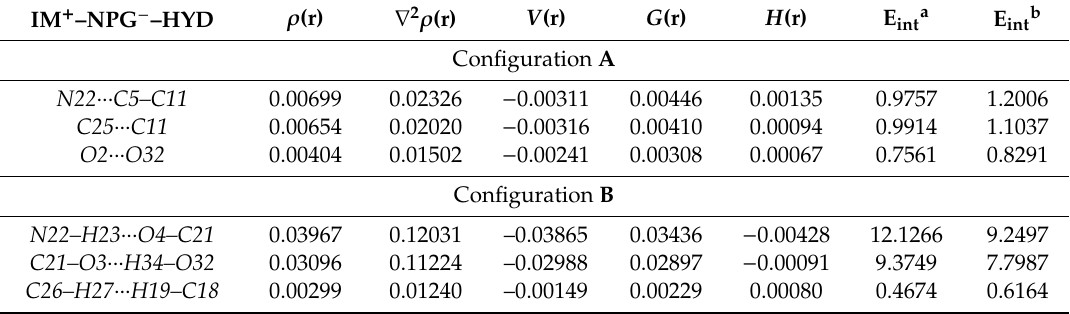
Table 4. Topological parameters of electron density: electron density ( ρ (r)), electron-density Laplacian distribution ( ∇ 2 ρ (r)), potential-energy density ( V (r)), kinetic-energy density ( G (r)), and electronic-energy density ( H (r)) at the BCPs (3, − 1), corresponding to the non-covalent interactions in IM + –NPG − –HYD , as well as the energies for these interactions (E int (kcal / mol)), defined by two approaches. Parameters all in